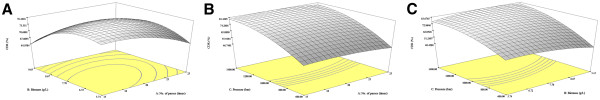
Response surface 3D contour plots for effect of three main variables on cell disruption capability as (A) Number of passes and Biomass concentration; (B) Number of passes and Pulse pressure; and (C) Biomass concentration and Pulse pressure. When the effect of two variables was plotted, the other factor was set at middle level point.